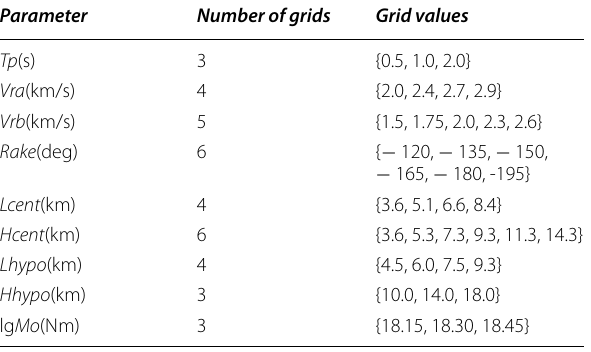
Table 6 Set of the grid parameter values for the GS search Parameter